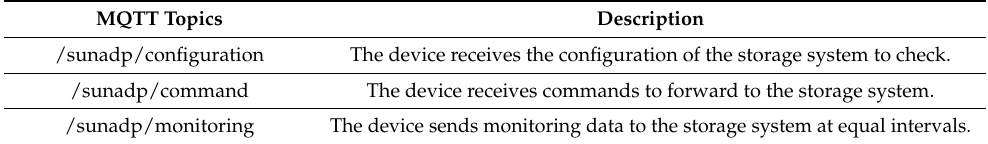
Table 3. List of read requests.